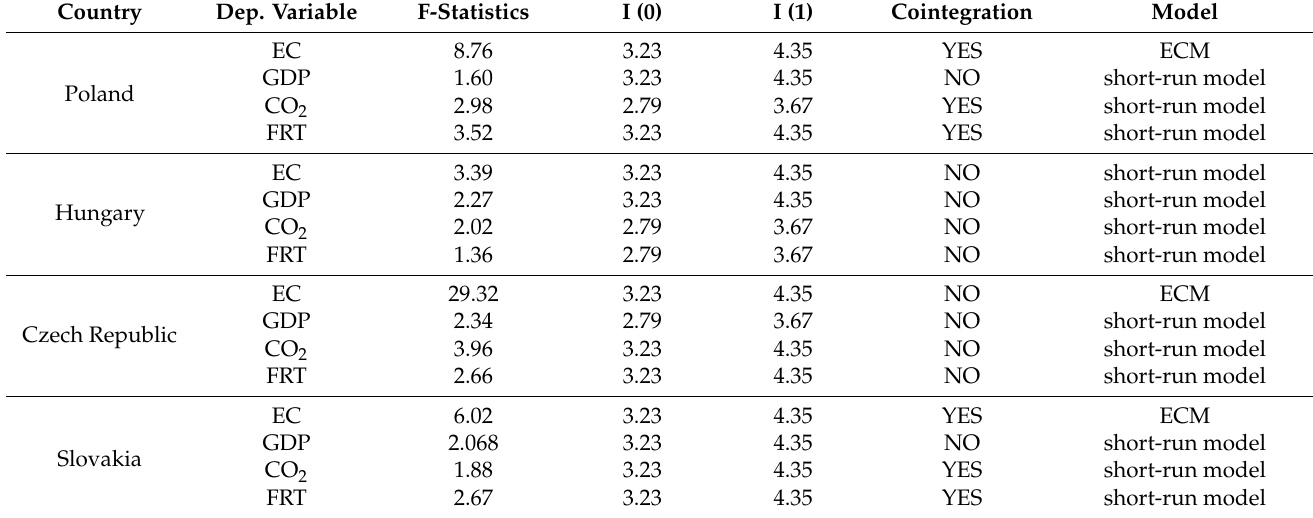
Table 5. The ARDL bound testing for integration with critical values. Country Dep. Variable